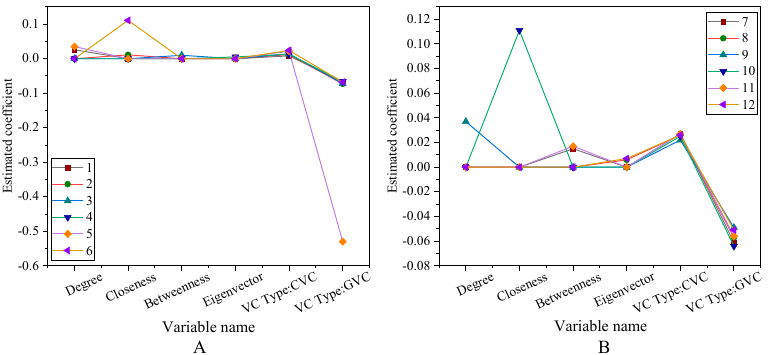
Figure 12. Robustness test for portfolio successful exit rates ( A ) The first six variables 1–6. ( B ) The first six variables 7–12.